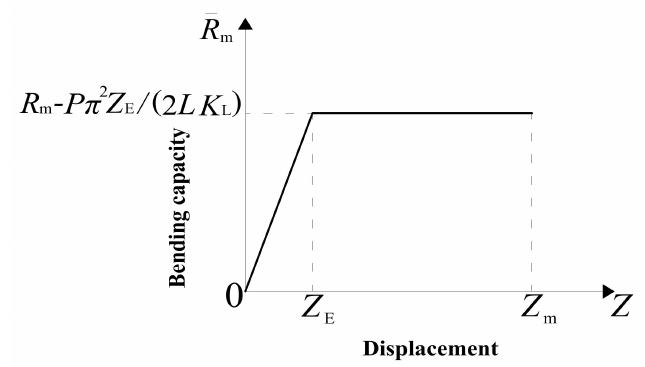
Figure 2. Bending resistance function.